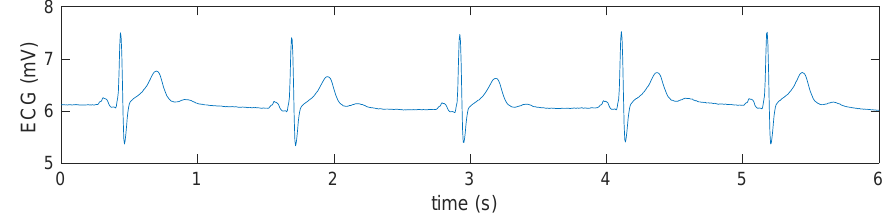
Figure 18. Raw ECG signal sampled at 200